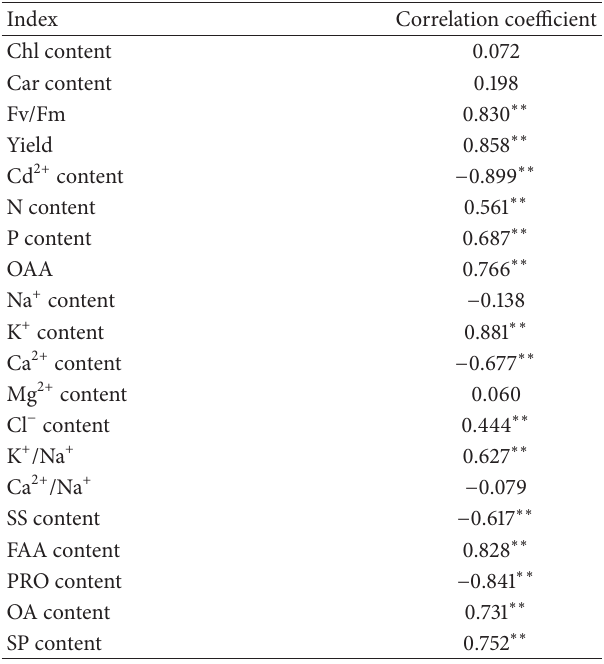
Table 3: Correlation coefficients between RGR and other indices for U. prolifera and U. linza